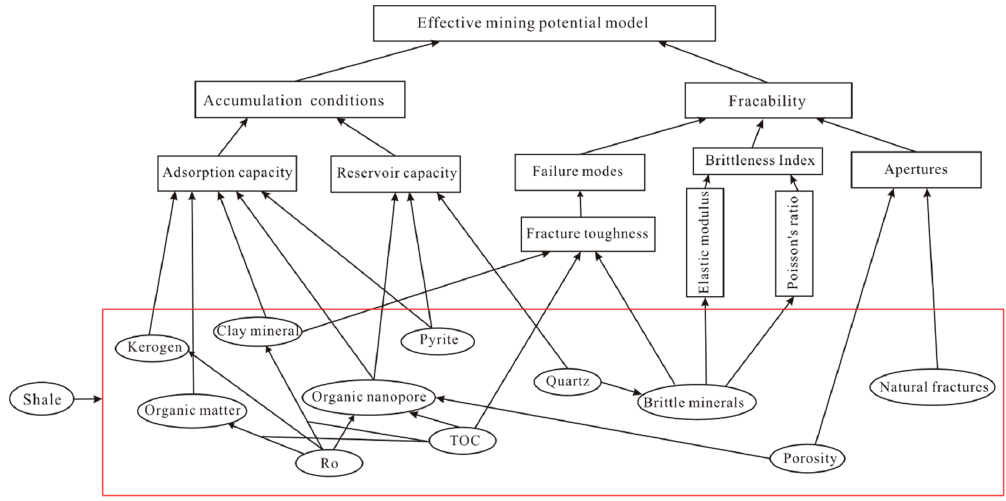
Figure 12. The framework for evaluating effective exploitation potential of a shale gas reservoir.